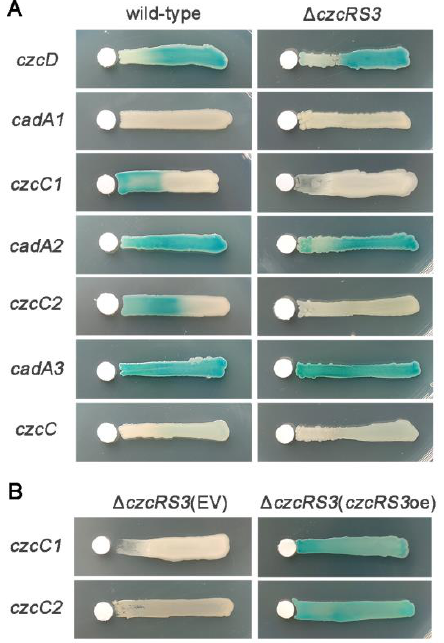
Figure 2. Role of CzcRS3 in the expression of efflux pump encoding genes. ( A ) The lacZ reporter plasmids carrying the promoter of indicated genes (the first gene of the operons) were introduced into wild-type KT2440 and deletion Δ czcRS3 . ( B ) The empty vector pBBR1-403 (EV) and pB403- czcRS3 ( czcRS3 oe) were introduced into the ∆ czcRS3 strains harboring the reporter plasmid for either czcC1 or czcC2 . The fresh bacterial cultures were streaked on the LB agar containing 40 µ g/mL X-gal (5-bromo-4-chloro-3- indolyl β -D-galactopyranoside). The filter paper pieces on the left side were supplemented with 4 μL of 0.1 M CdCl 2 . The blue substance, which is the hydrolyzed product of X-gal by LacZ, indicates activation of the tested promoters. The photos were taken after 4 d of incubation.